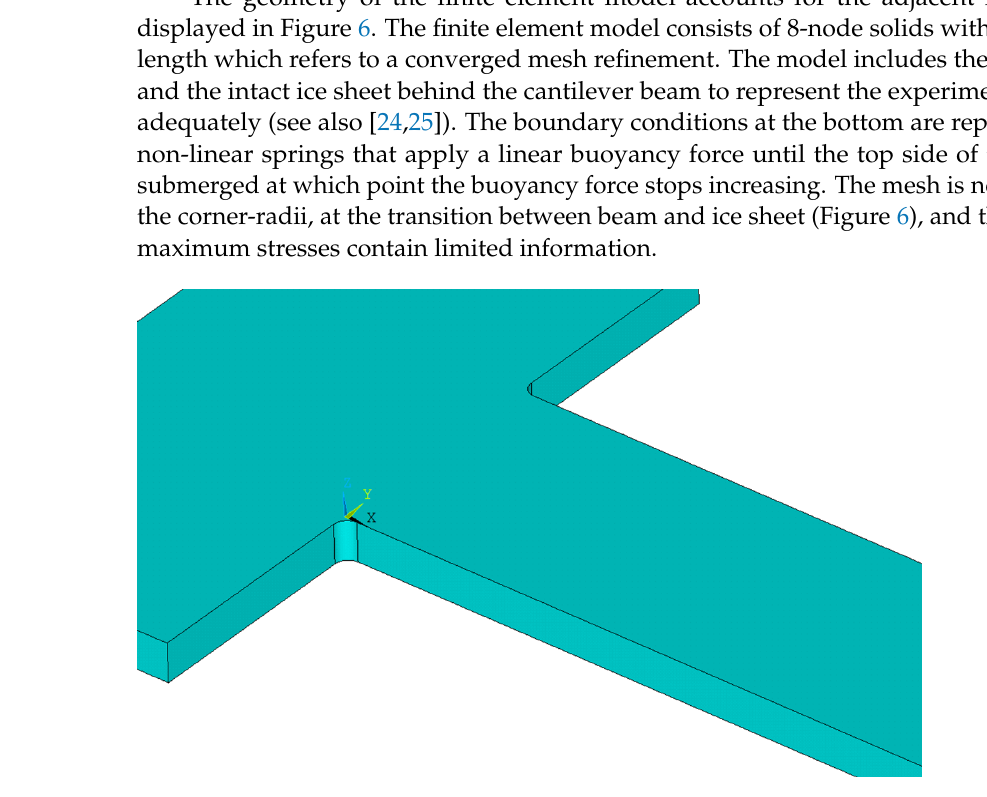
Figure 6. Geometry of the FE model which includes a part of the adjacent ice